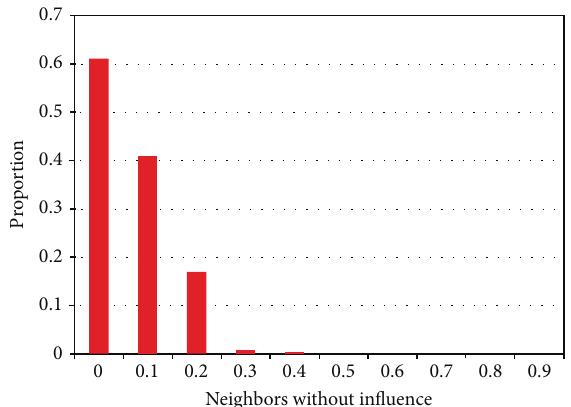
Figure 9: Individual neighbor distribution of the proposed complex